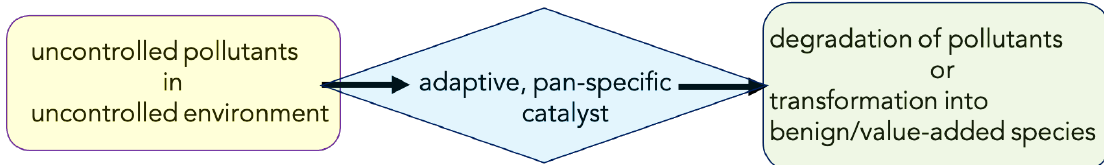
Figure 9. Scheme representing the main challenges of environmental remediation processes and the main features that may enable the catalysts to efficiently remove toxic species or convert them into benign/value-added products.